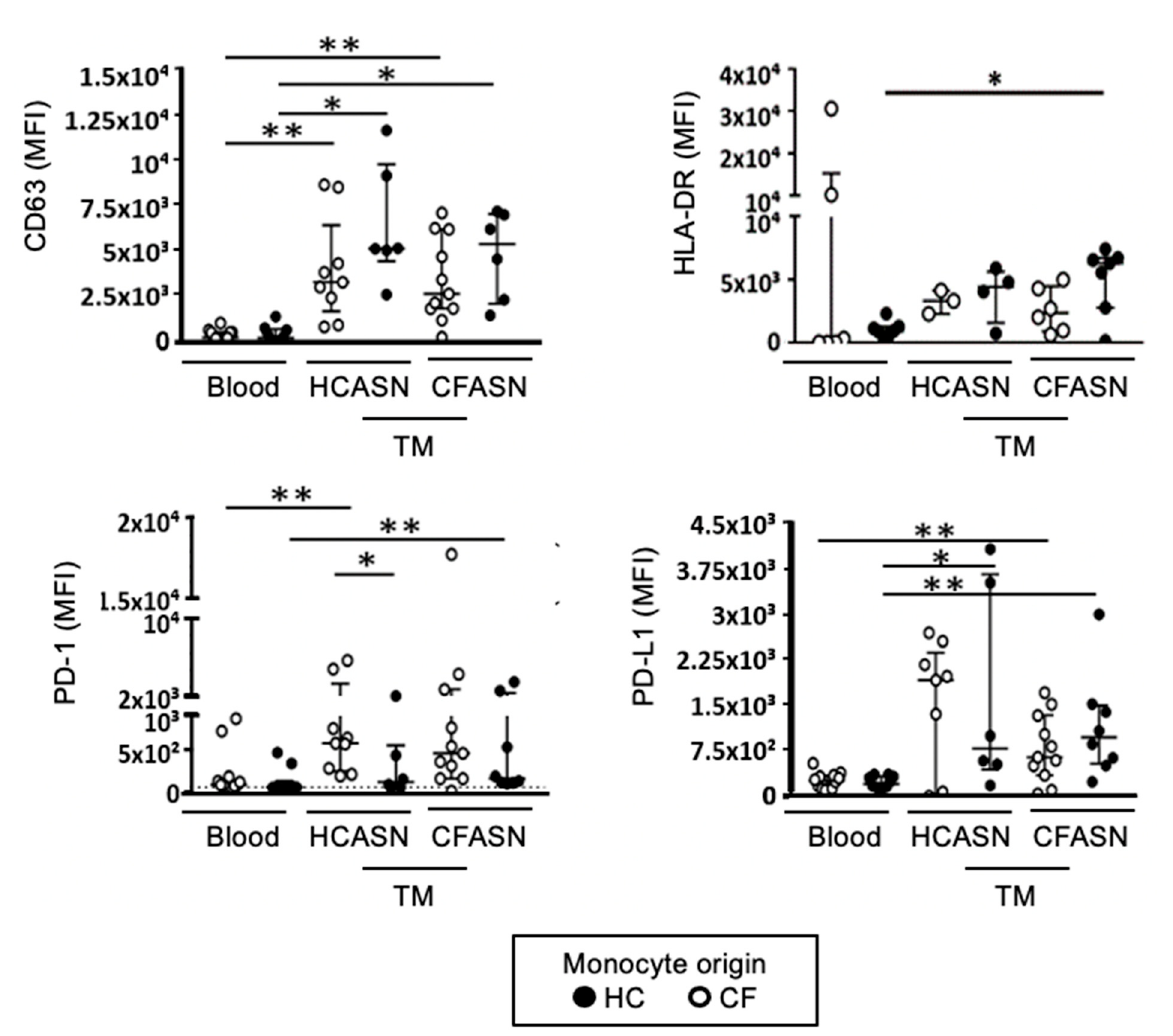
Figure 4. Expression of select activation markers on transmigrated monocytes. Blood monocytes from HC or CF donors transmigrated into HCASN or CFASN were subjected to flow cytometric analysis to compare expression of activation markers across subsets of transmigrated monocytes. Statistics: Mann–Whitney test for different monocytes (HC vs. CF) recruited to the same ASN (HC or CF) and Wilcoxon signed rank test for the same monocytes (HC or CF) recruited to different ASN (HC vs. CF). * and ** mark p < 0.05 and p < 0.01, respectively. n = 4–11 depending on condition. Non-significant differences not shown.